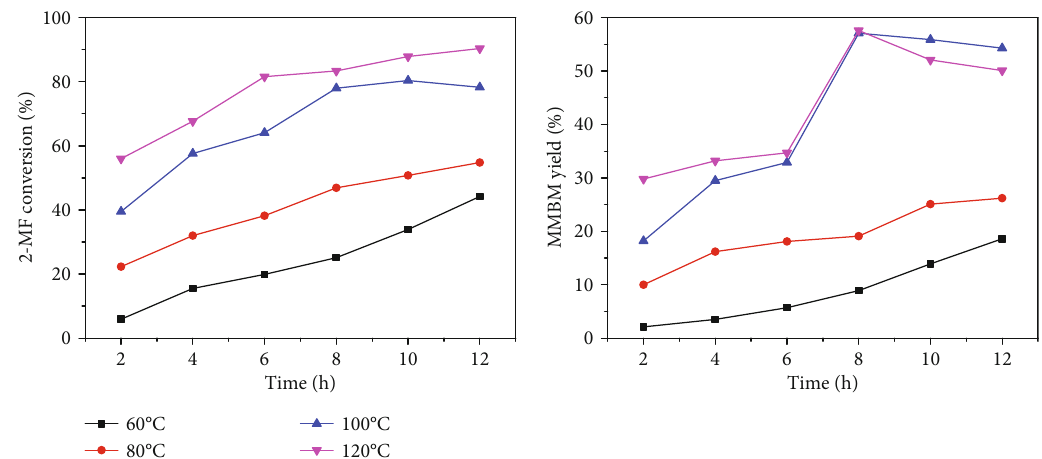
Figure 6: In fl uence of reaction temperature/time on the conversion of HMF and 2-MF to MMBM. Reaction conditions: 3mmol 2-MF, 1mmol HMF, 20 mg 3-BrPyPW, and 2mL CH